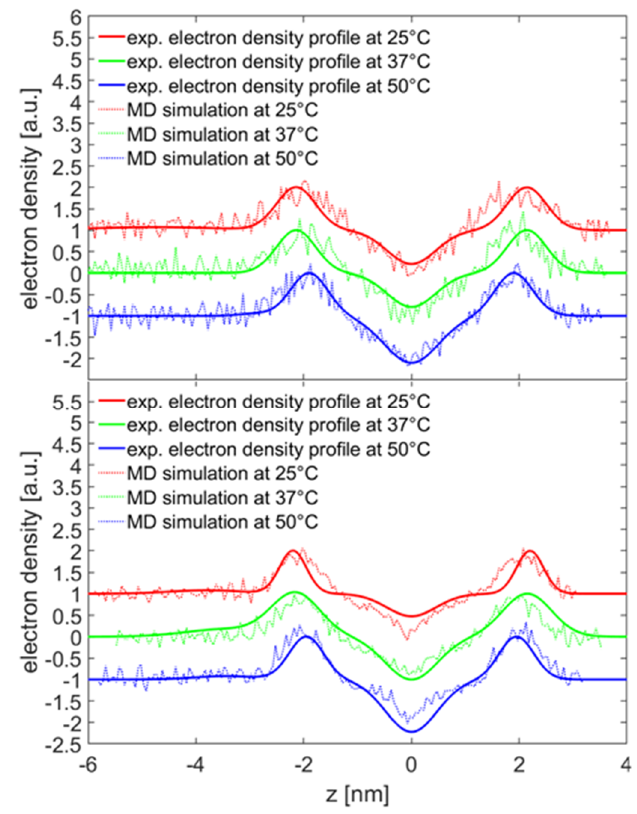
Figure 8. Electron density profile of the simulated DPPC bilayer with adsorbed HA.